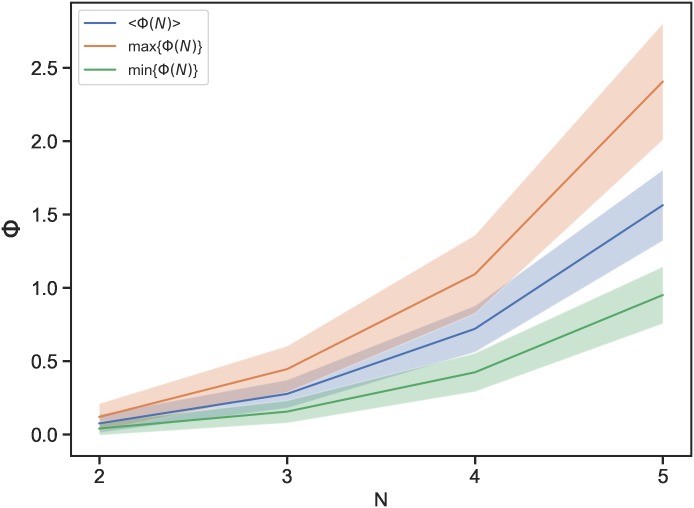
〈Φ〉, maxΦ(N), and minΦ(N) values of time-homogeneous Markov chains with different values of N.The Φ values were calculated for randomly generated 100 transition probability matrices (TPMs). The shadows indicate the standard deviations.